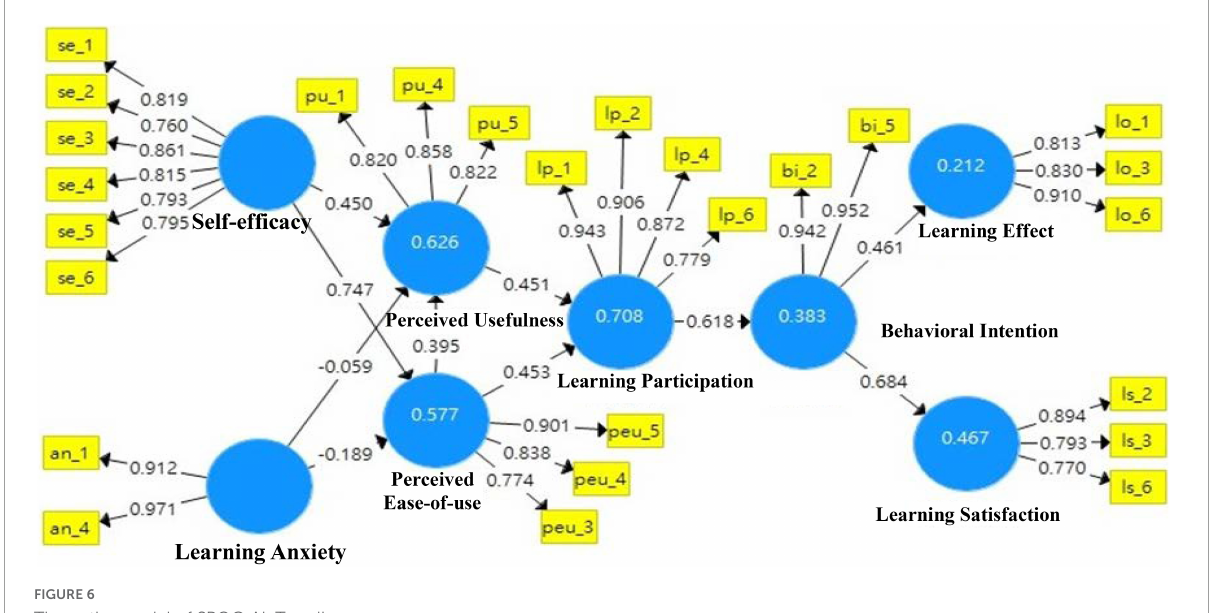
FIGURE6 The entire model of SPOC-AIoT